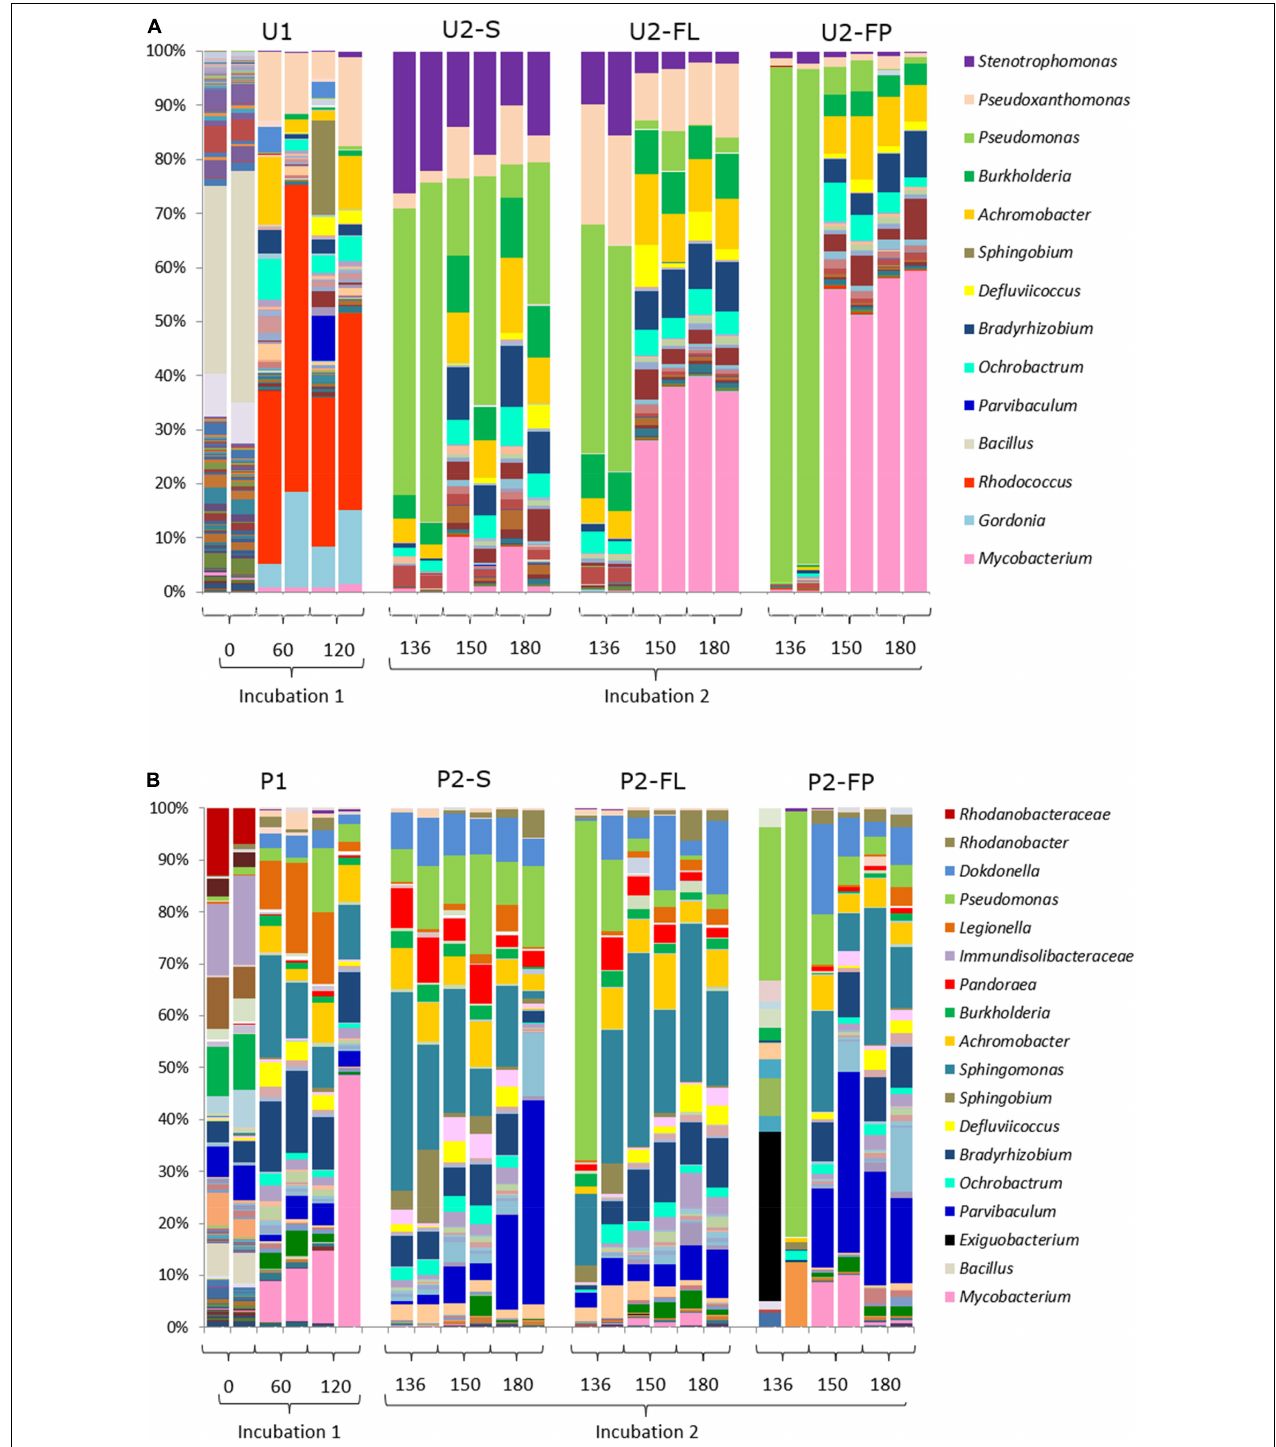
FIGURE 4 | Bacterial community fingerprints. (A) Succession of the microbial community from untreated soil (community U); (B) Succession of the microbial community from a landfarming experiment (community P). Bar plots are from biological duplicates. Numbers are days. One aliquot of incubation 1 was incubated in two different setups: a medium containing oil in suspension and a medium containing oil absorbed into polypropylene particles (filter-liquid and filter-pellet). Naming legend: 1 and 2 indicate the incubation number, S liquid flasks with oil in suspension, FL liquid from cultures with oil absorbent material (filter liquid), FP biomass detached from polypropylene particles in cultures with oil-absorbing material (filter